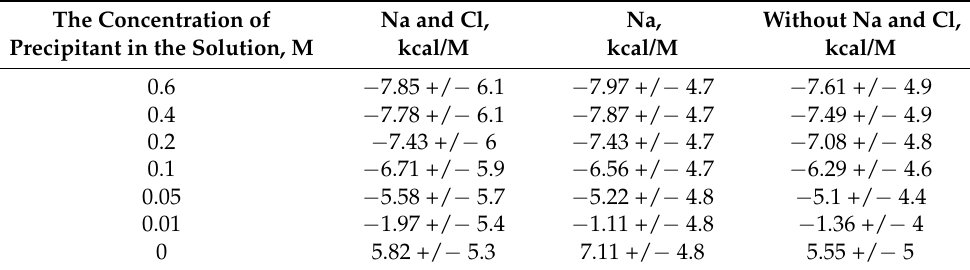
Table 1. Comparison of changes in free energy upon the binding of lysozyme monomers with different combinations of precipitant ions bound to the protein (Na and Cl, only Na, without Na and Cl) in solutions with the addition of NaCl at various concentrations. The standard deviation for ∆ G is provided (the standard deviation of the mean value is a factor of n 1/2 lower, where n is the number of snapshots and equals 1000). The Concentration of Precipitant in the Solution,